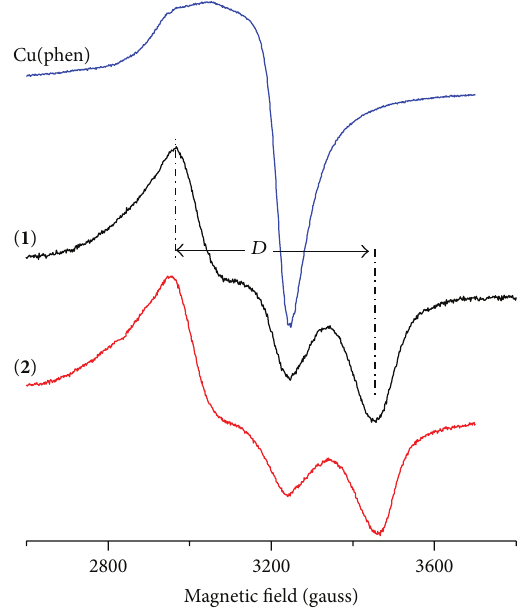
Figure 3: EPR spectra of [CuCl 2 (phen)] and complexes 1 and 2 in water ( ∼ 10 −3 mol L −1 ) at 77 K.